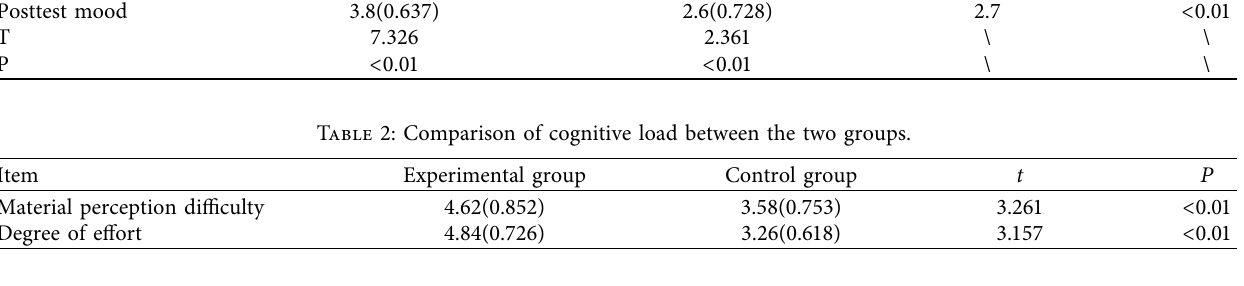
Table 3: Comparison of learning effects between the two groups of students.